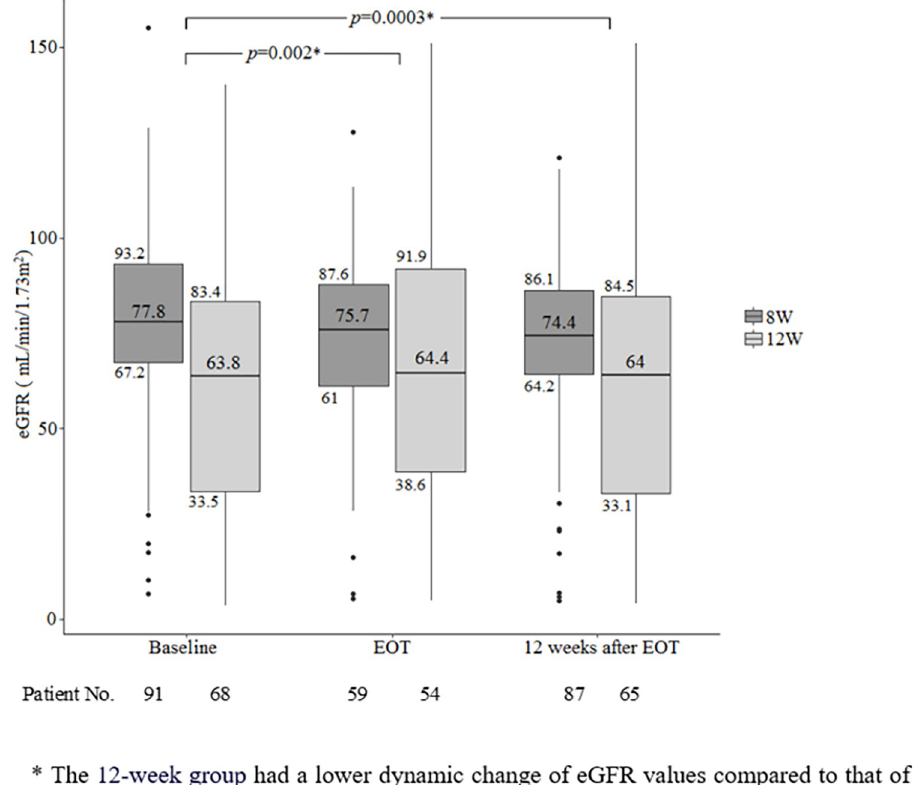
Fig 3. Dynamic changes of eGFR during and after GLE/PIB